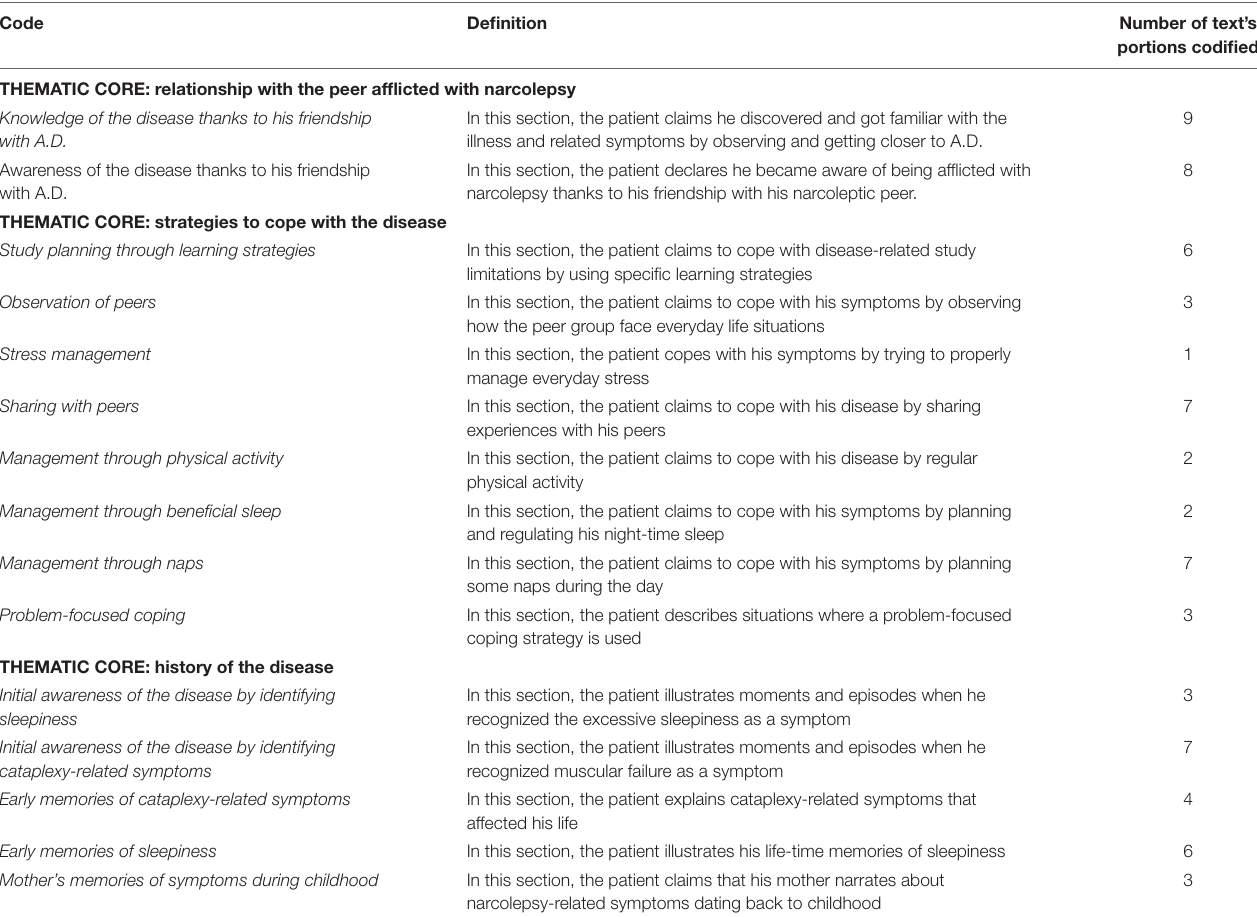
portions codified